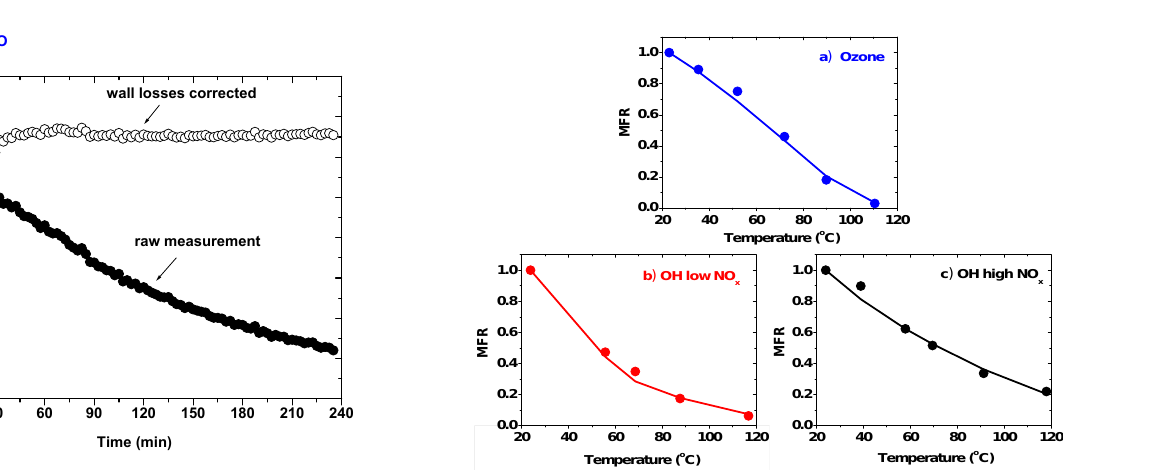
Figure 8. The thermograms (mass fraction remaining, MFR, as a function of temperature) of the three different reaction systems. The circles represent the experimental data, while the lines are the fitting of the